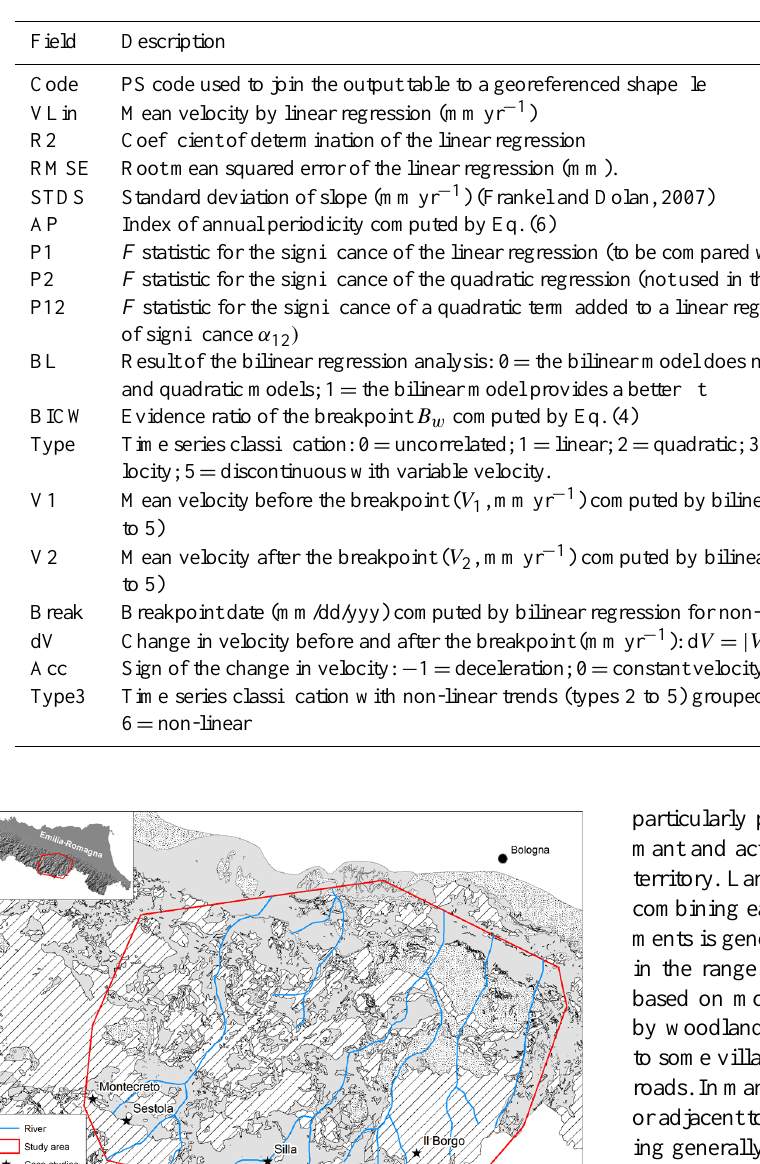
Table 1. Output table provided by PS-Time.